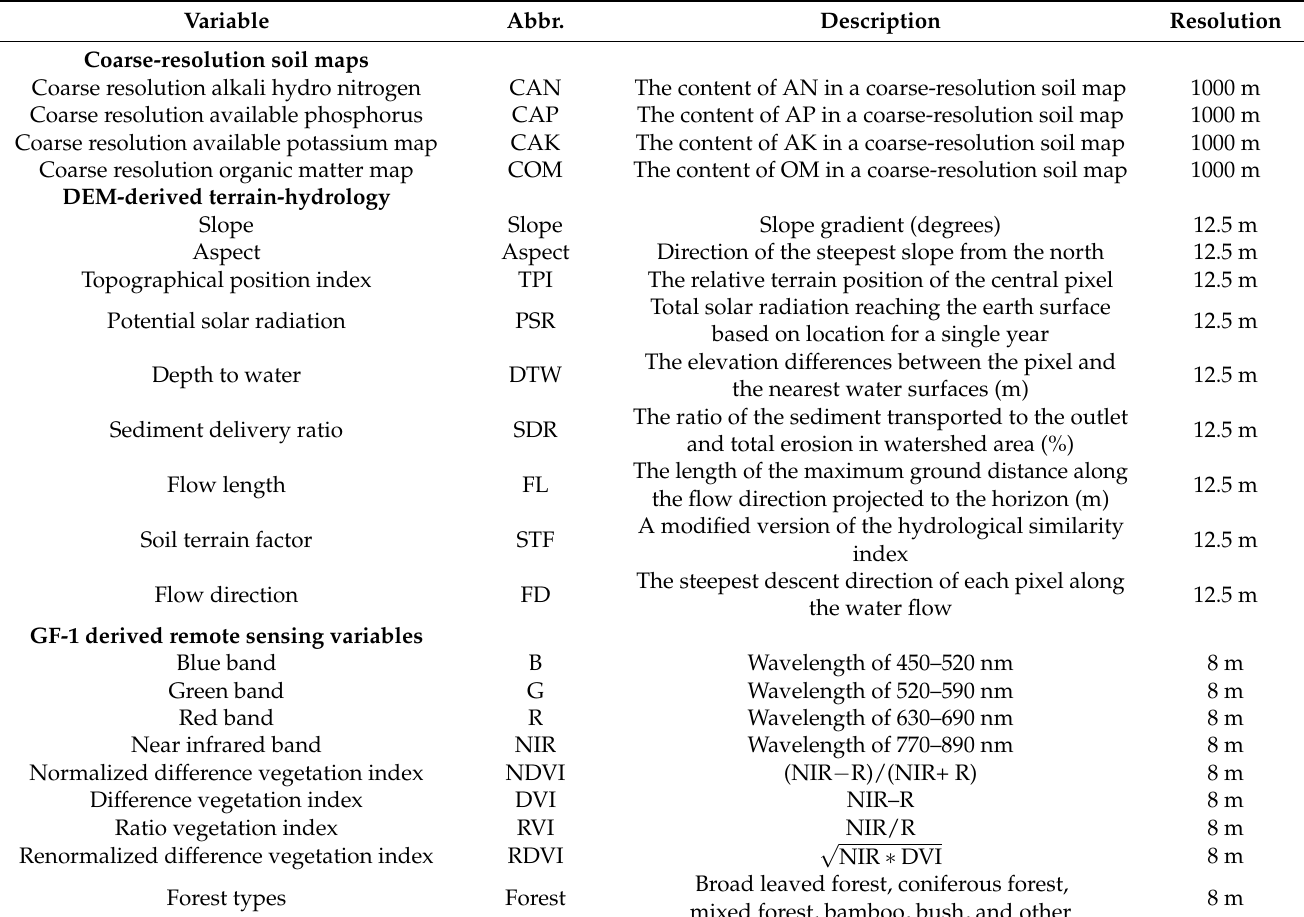
Table 1. Input variables for Model A, Model B, and Model